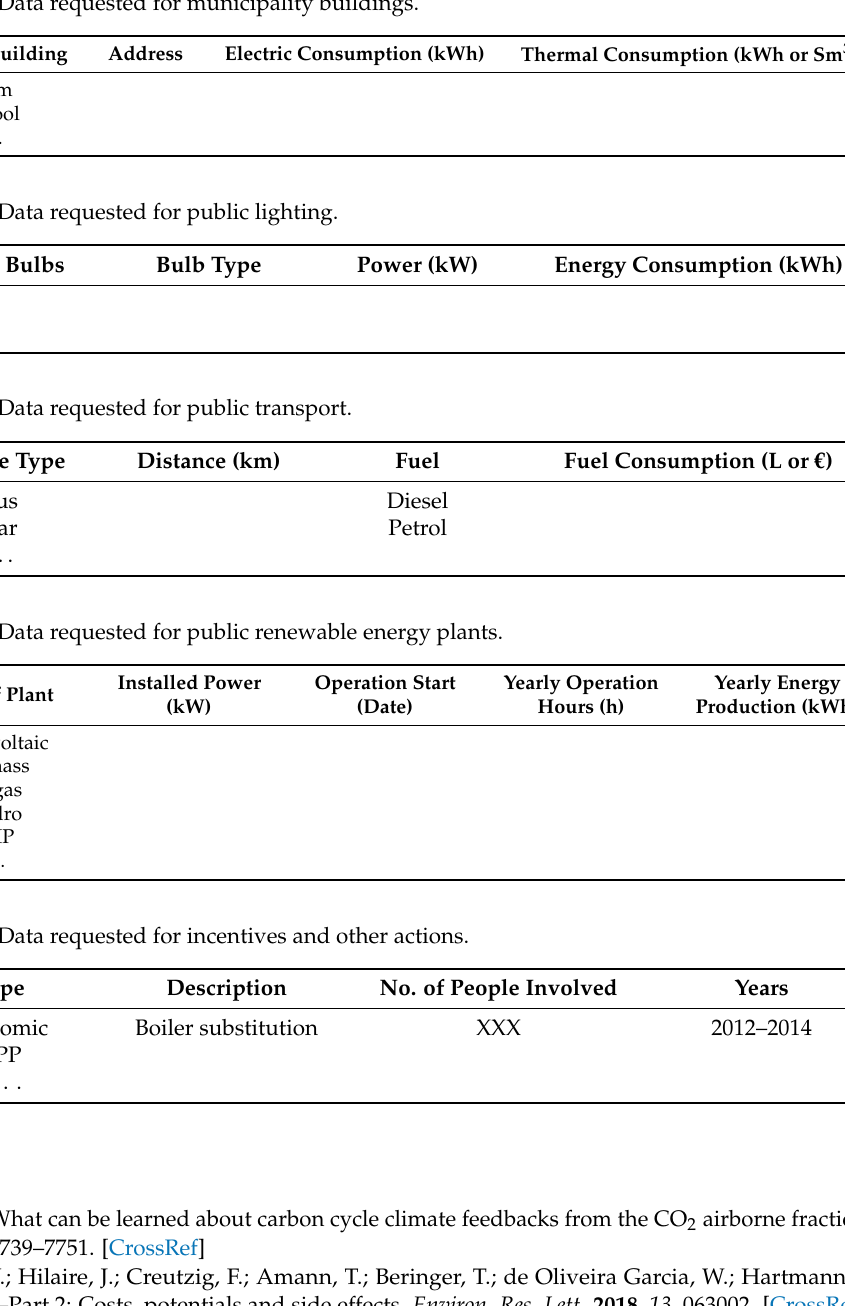
Table A1. Data requested for municipality buildings.